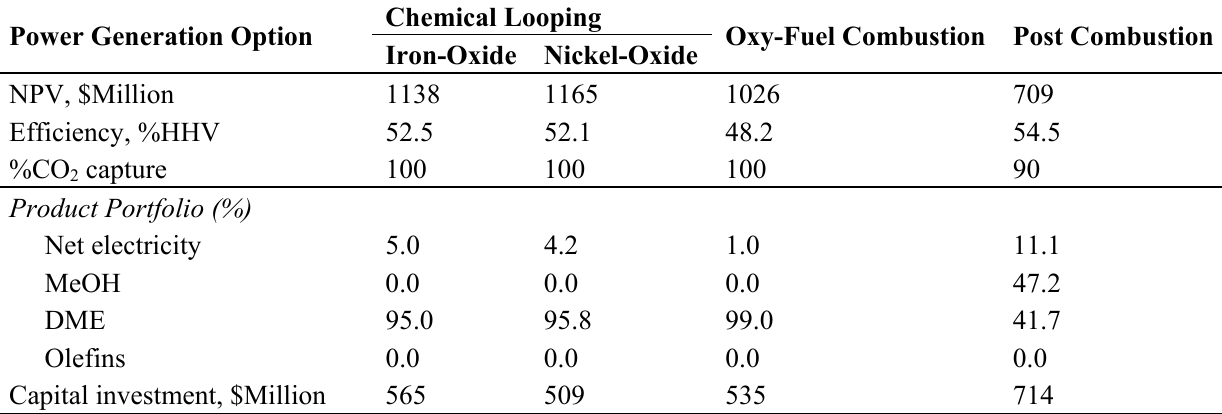
Table 3. Comparison of the power generation options using Fayetteville shale